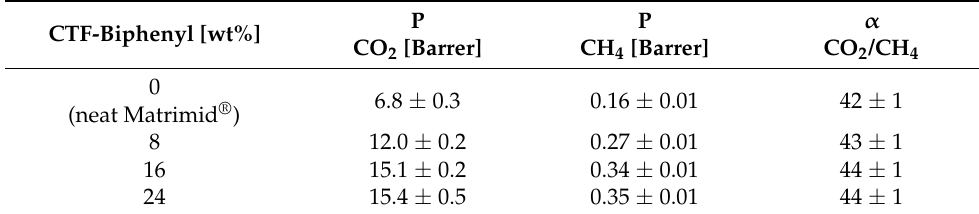
Table 1. Gas permeabilities ( P ) and mixed-gas selectivity factors ( α ) of the pure Matrimid ® membrane and CTF/Matrimid ® MMMs 1 .